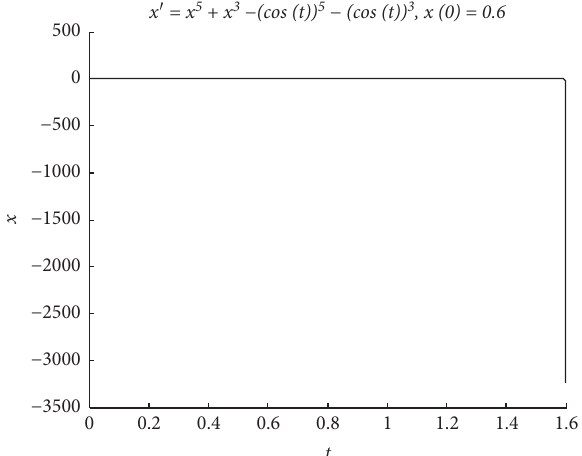
Figure 2: The curve of the solution of equation (81) with initial value x ( 0 ) � 0 .